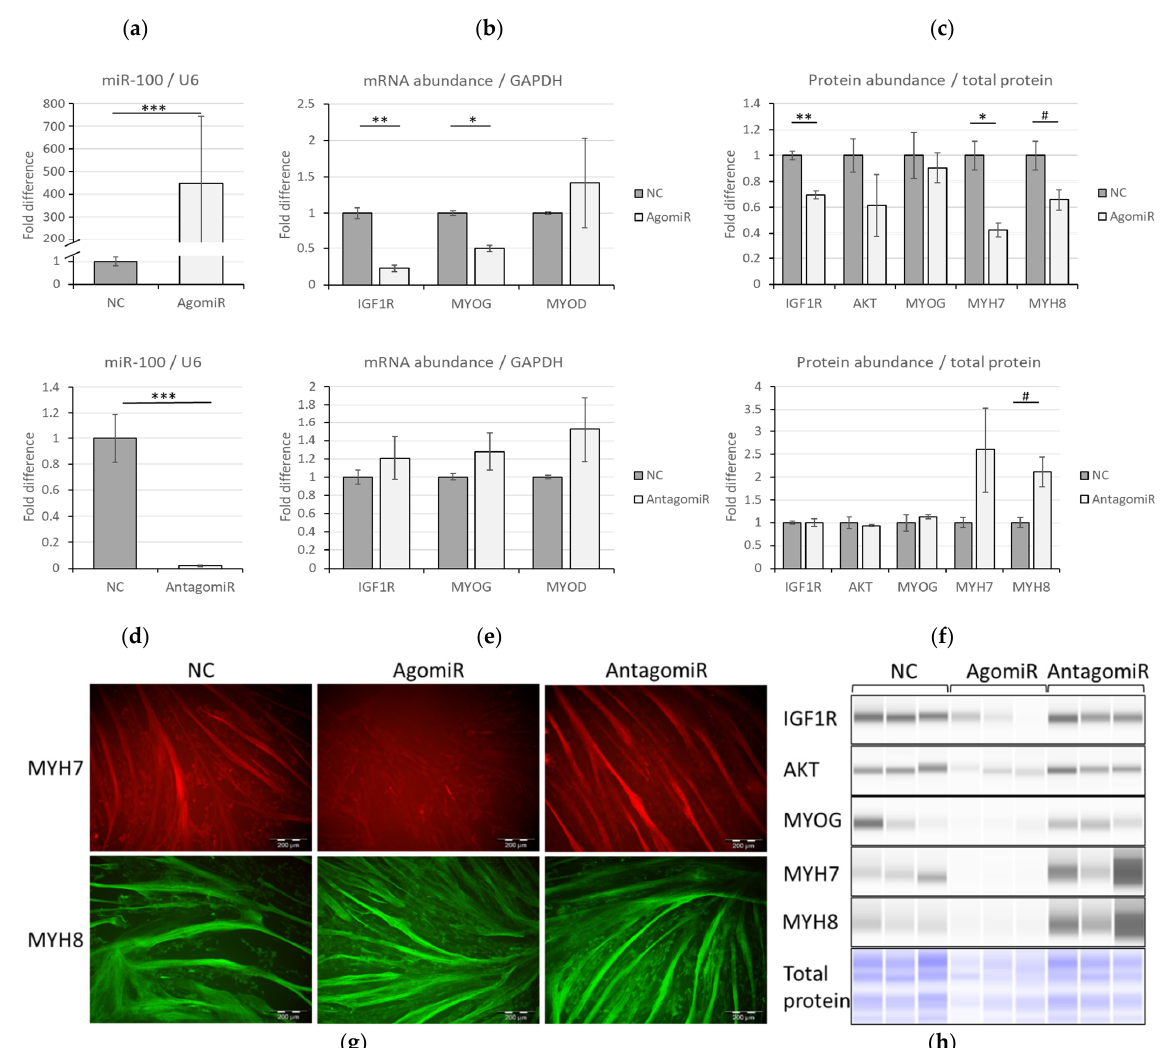
Figure 3. Overexpression and inhibition effects of miR-100 in myotubes. Overexpression of miR-100 in BMSC myotubes compared to negative control (NC) caused by agomiR ( a ) and the impact of this intervention on IGF1R, MYOG, and MYOD transcript levels ( b ) and protein abundances ( c ). The impact of antagomiR on miR-100 levels ( d ), IGF1R, MYOG, and MYOD levels ( e ) as well as on IGF1R, AKT, MYOG, MYH7, and MYH8 protein abundances ( f ). Protein abundances were determined through Jess Simple Western and normalized to total protein. Virtual blot images are shown ( h ), as well as immunocytochemical staining of MYH7 and MYH8 ( g ). Data is representative of three independent experimental replicates per sample group where expression levels are presented as fold differences. Significant differences to NC are indicated with * if p < 0.05, ** if p < 0.01, *** if p < 0.001 and a trend is indicated with # (0.05 < p <